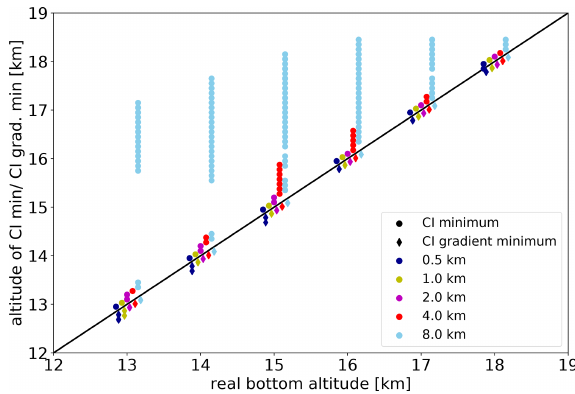
Figure 8. The altitude of the CI minimum (full circles) and the CI gradient minimum (full diamonds) against the real bottom altitude. The black line shows the line with a slope of one. The different cloud thicknesses are shown using colour coding, and the points have been shifted along the line for the sake of clarity. Clouds with a CI minimum < 1.2 (optically thick) and > 5.0 (optically thin) have been